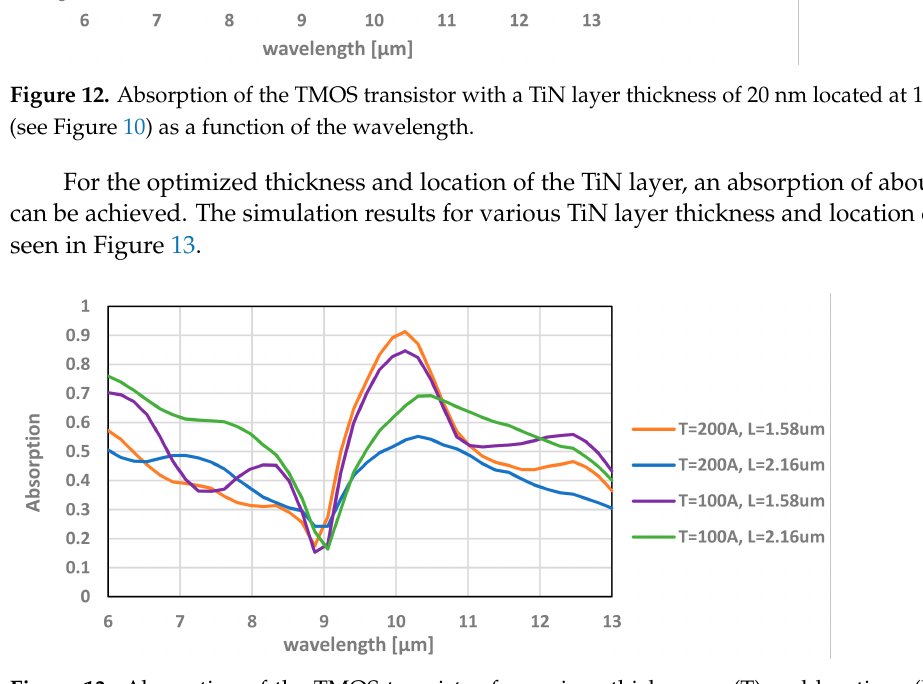
Figure 13. Absorption of the TMOS transistor for various thicknesses (T) and locations (L) as a function of the wavelength.